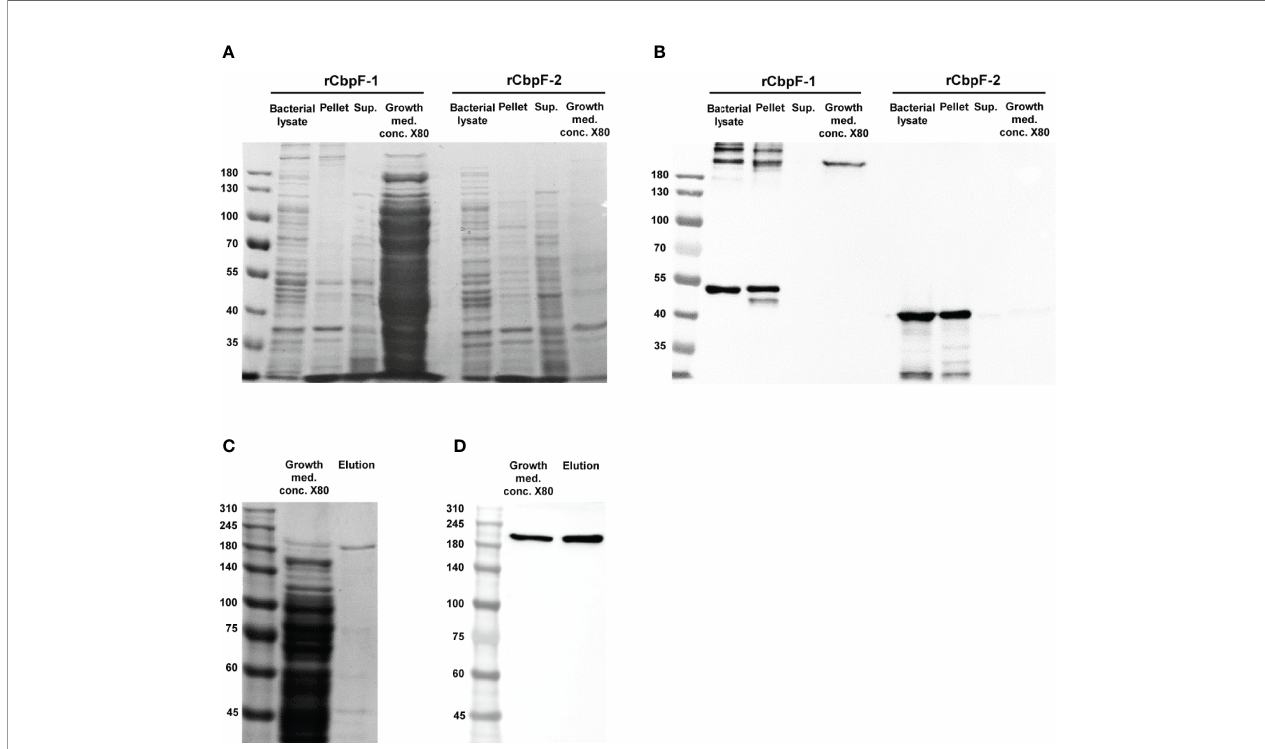
FIGURE 1 | Expression of cbpF -1 and cbpF -2, and puri fi cation of rCbpF-1. cbpF -1 and cbp F-2 were expressed in E. coli C43 transformed with pSA-OCbpF1 and pSA-OCbpF2 respectively. Whole bacterial lysate, Pellet and Supernatant (Sup.) fractions after bacterial lysis, and growth medium concentrated X80 (Growth med. conc. X80) of E. coli C43 expressing either cbpF -1 or cbpF -2 were subjected to 7.5% gels SDS-PAGE (A) , and Western immunodetection using anti-His monoclonal antibody (B) . Recombinant CbpF-1 (rCbpF-1) was puri fi ed using Ni-NTA from growth medium concentrated X80 and subjected to 6% SDS-PAGE (C) , and